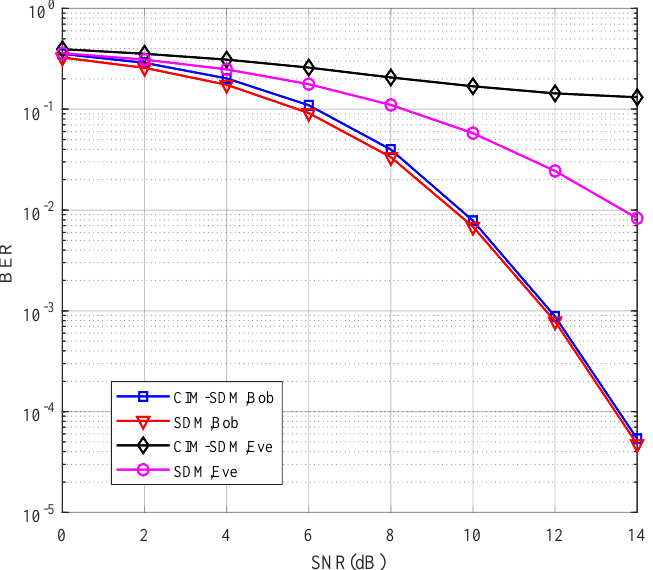
Figure 9. Bob’s and Eve’s BER performances for the proposed CIM-SDM scheme in comparison to the traditional SDM counterparts employing N t = 8, N r = 4, and